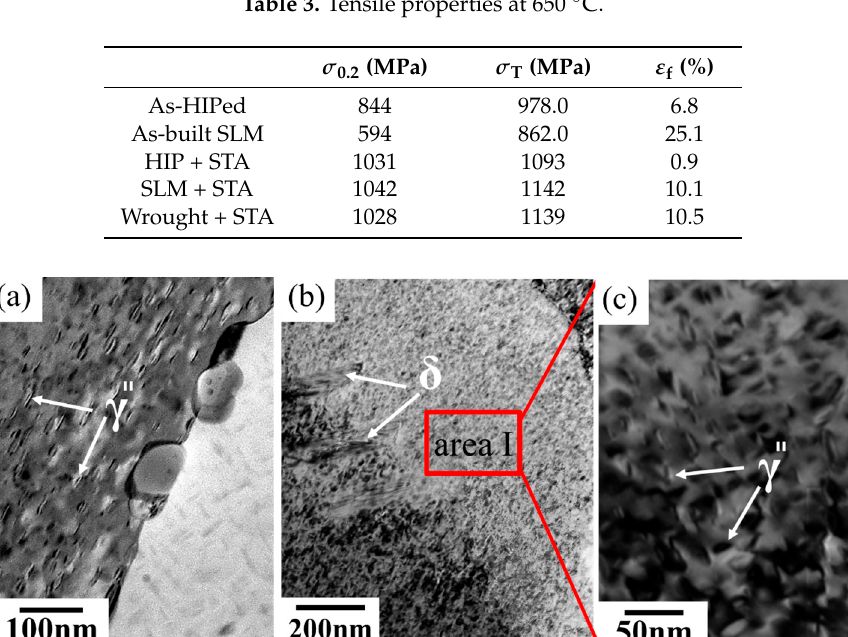
Figure 10. TEM bright field micrograph of strengthening phase precipitate within ( a ) HIP + STA and ( b ) SLM + STA specimens and ( c ) high magnification of area I in ( b ).